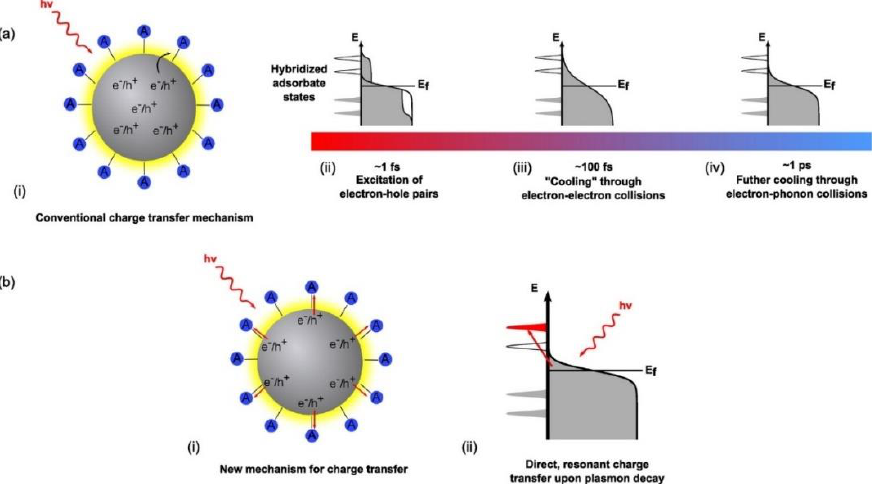
Figure 5. Modes of charge transfer and relaxation mechanisms in metal nanostructures. Ref [117] In the conventional charge transfer mechanism ( a ), resonant photon absorption creates hot electron-hole pairs within the metal nanostructure. What begins as an equilibrium thermal distribution of charge carriers in the metal nanostructure rapidly changes (i) to a nonequilibrium athermal hot electron distribution (~1 fs) (that cannot be described by Fermi–Dirac statistics) (ii) Hot electrons are now continuously transferred to the conduction band of the semiconductor from the tail portion of the electron distribution of the noble metal (iii) This athermal distribution rapidly dephases or cools through electron–electron collisions taking place on the order of ~100 fs. (iv) Further cooling through electron phonon collisions occurs on the order of ~1 ps resulting in the thermalization of the initial athermal distribution and a subsequent relaxation towards equilibrium. Alternatively, in ( b ) there is the Dissociation Induced Electron Transfer (DIET) mechanism, where electrons generated under excitation are directly injected into the conduction band of the semiconductor without and before any further interactions with other electrons. (ii) It is a direct, resonant transfer of charge carriers that circumvents the thermalization and relaxation mechanisms of hot electrons depicted in the sequential mechanism in ( a ). Reprinted with permission from Ref [117] Copyright American Chemical Society